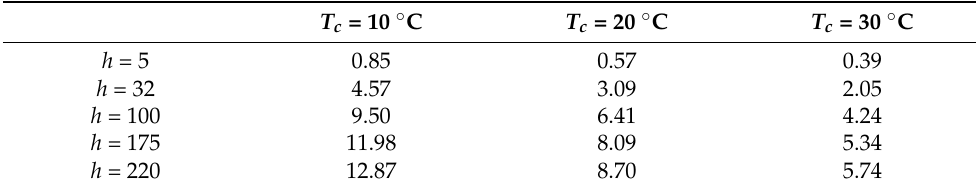
Table 11. Maximum local volumetric current density difference at the positive electrode ( ∆ j f,p,max_diff ) in the discharge process (10 4 A/m 3 ).